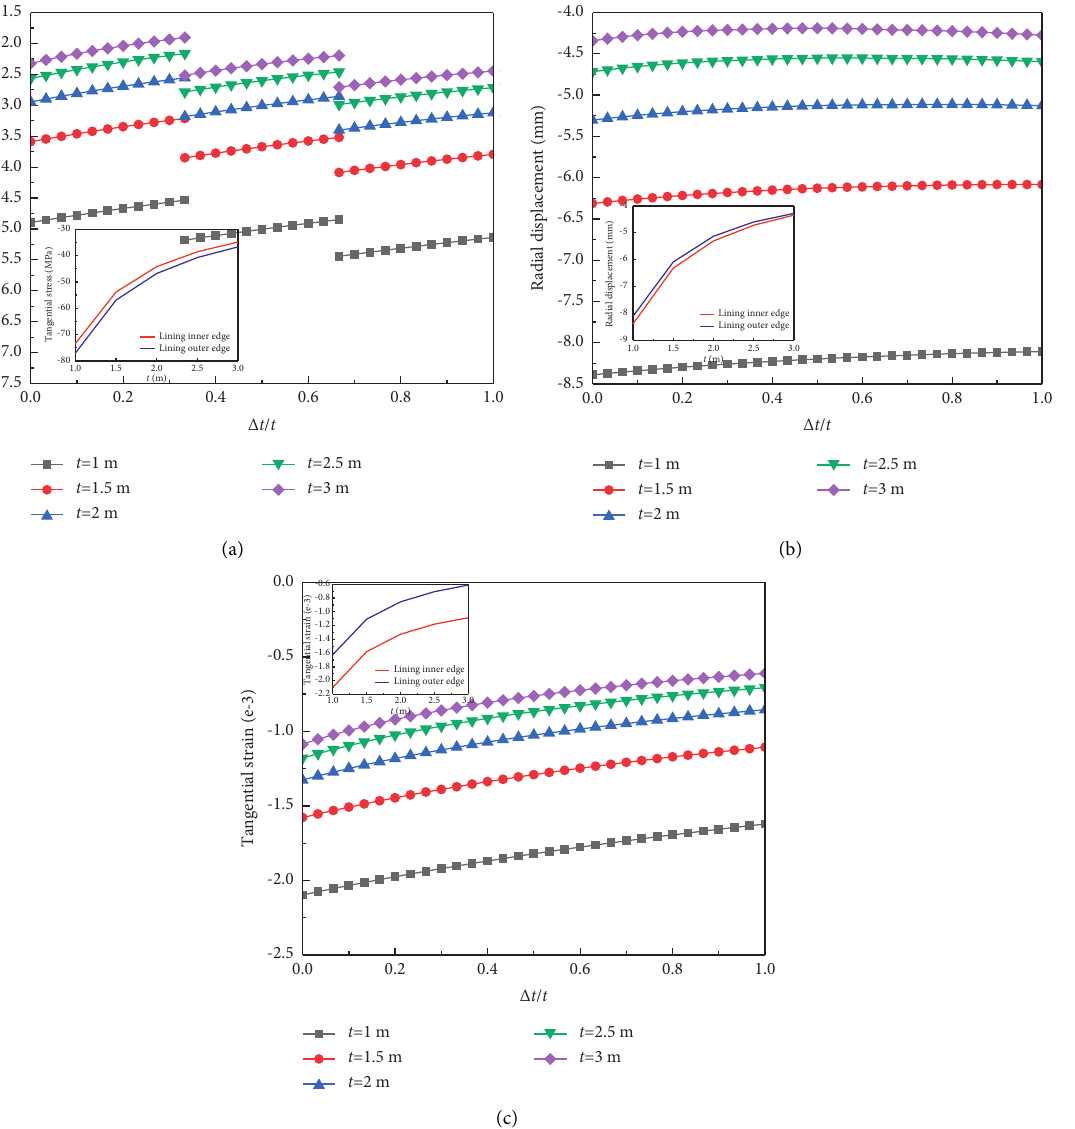
Figure 4: Variations in tangential stress, radial displacement and tangential strain of FGL with thickness t . (a) Tangential stress. (b) Radial displacement. (c) Tangential